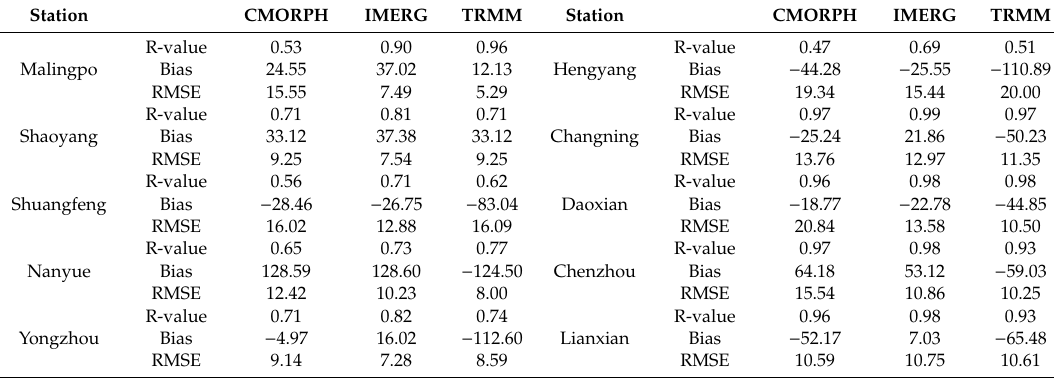
One-week AWD comparison between satellites and in situ observations at each meteorological station.